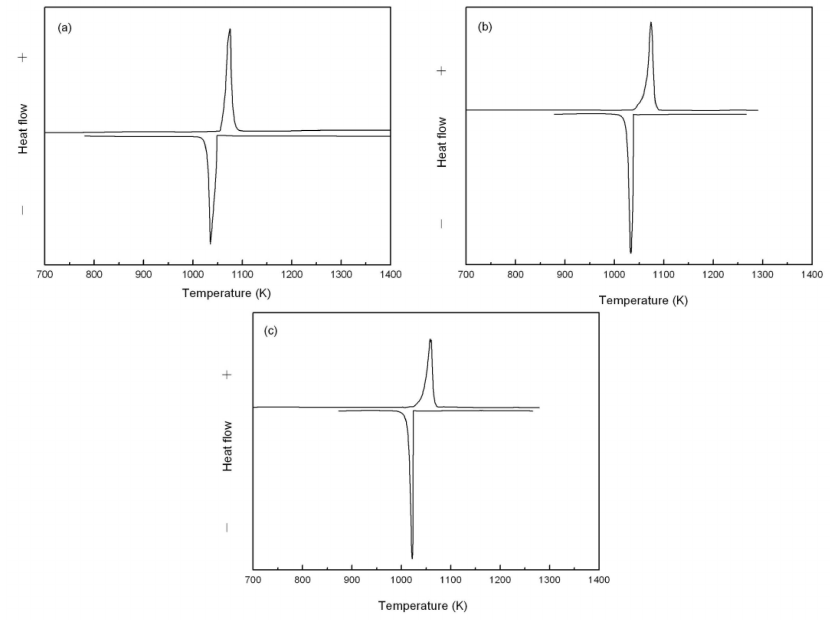
Figure 2. DSC curves of different alloys, ( a ) Ag-28.1Cu, ( b ) (Ag-28.1Cu)-0.5Sb, and ( c ) (Ag-28.1Cu)-1Sb.